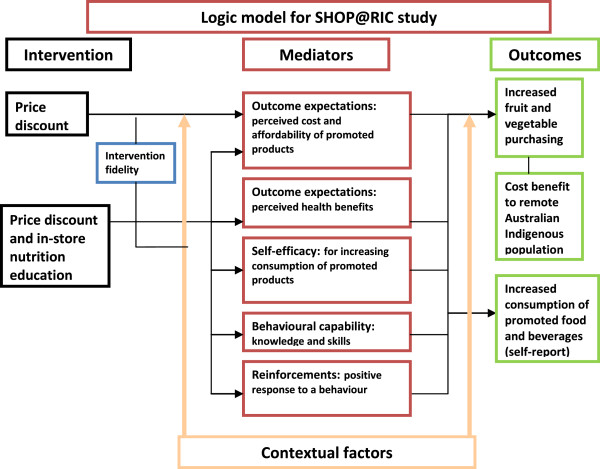
Study logic model.